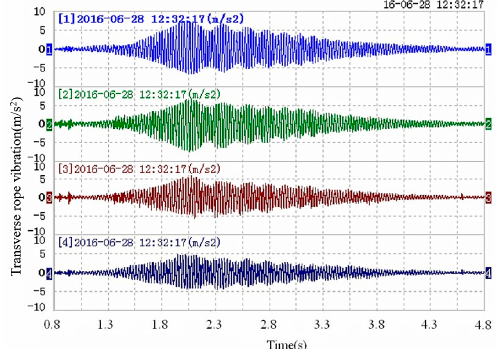
Figure 7. Local nonstationary rope vibration diagram for each measuring point. Appl. Sci. 2020 , 10 , 1305